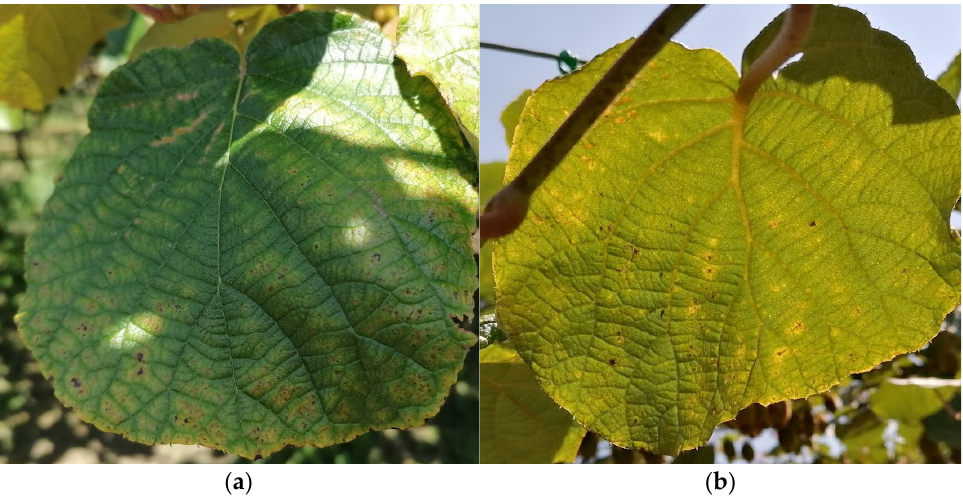
Figure 1. ( a ) Median of the spectra of the 25% observations best classified as ‘asymptomatic’ (green) Figure 1. Typical symptoms of Bacterial Canker of Kiwi (BCK) caused by Pseudomonas syringae pv. and ‘symptomatic’ (red) for the selected model, combining the SFVS with SVM with radial kernel actinidiae (Psa) on the adaxial ( a ) and abaxial ( b ) sides of leaves in an advanced stage of the and class weights (stepsvmrw); ( b ) Variance of the reflectance data measured by spectral wavelength and class (green line representing the variance in the mean spectra of ‘asymptomatic’ samples, and red line illustrating the variance in the mean data of ‘symptomatic’ leaves).